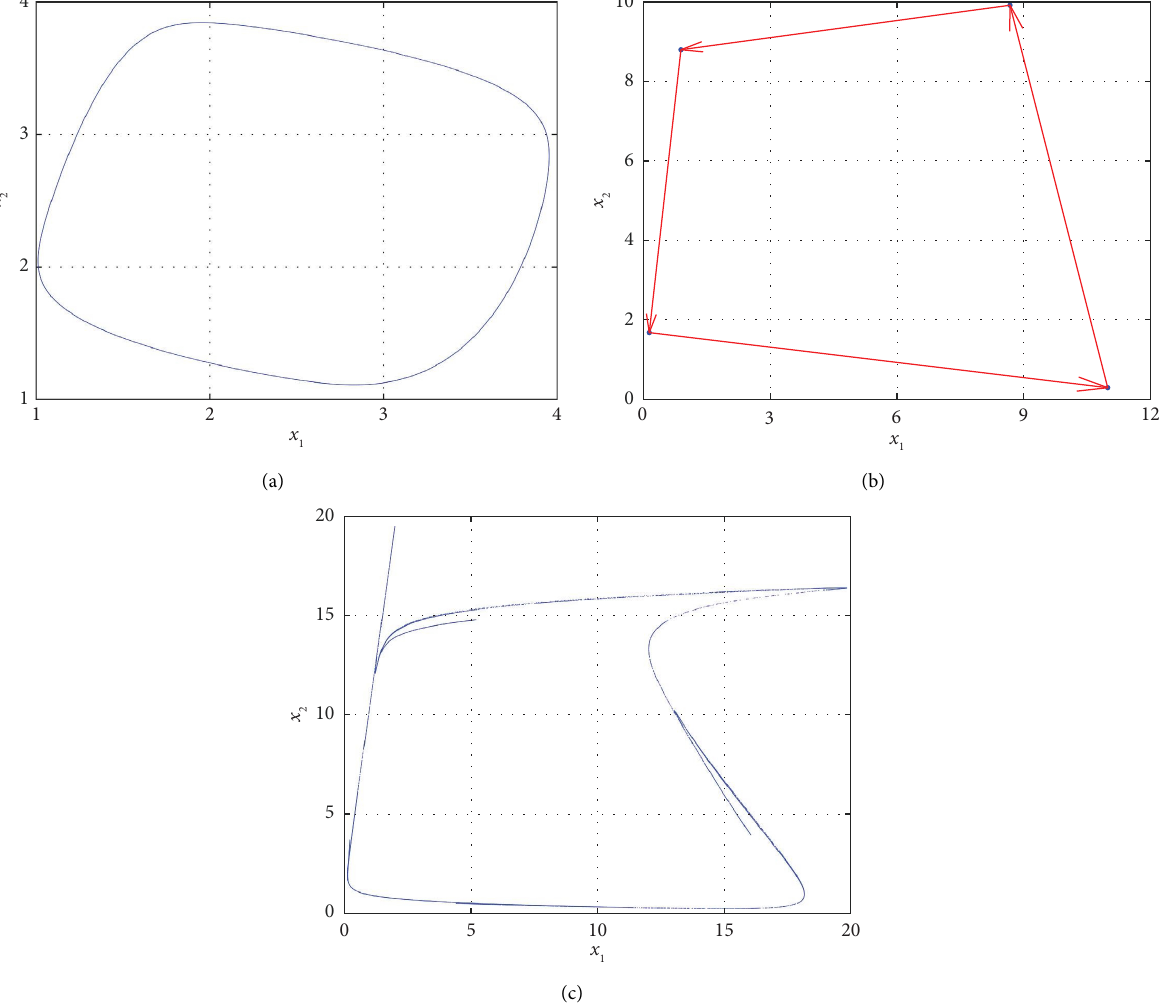
, μ ,p ) � ( 1 , 0 . 1 , 0 . 9 ) : (a) F � 10, (b) F � 35, and (c) F � 49. 1 2